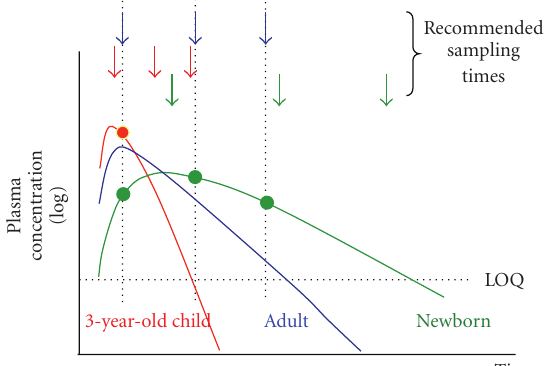
Figure 8: Schematic drawing of a potential application of PBPK simulations for children of di ff erent ages to find optimal blood sampling time points for the pharmacokinetic investigations in a future pediatric trial according to Willmann [54]. Arrows indicate optimal sampling time for a 3-year-old child, a newborn, and an adult. LOQ: limit of